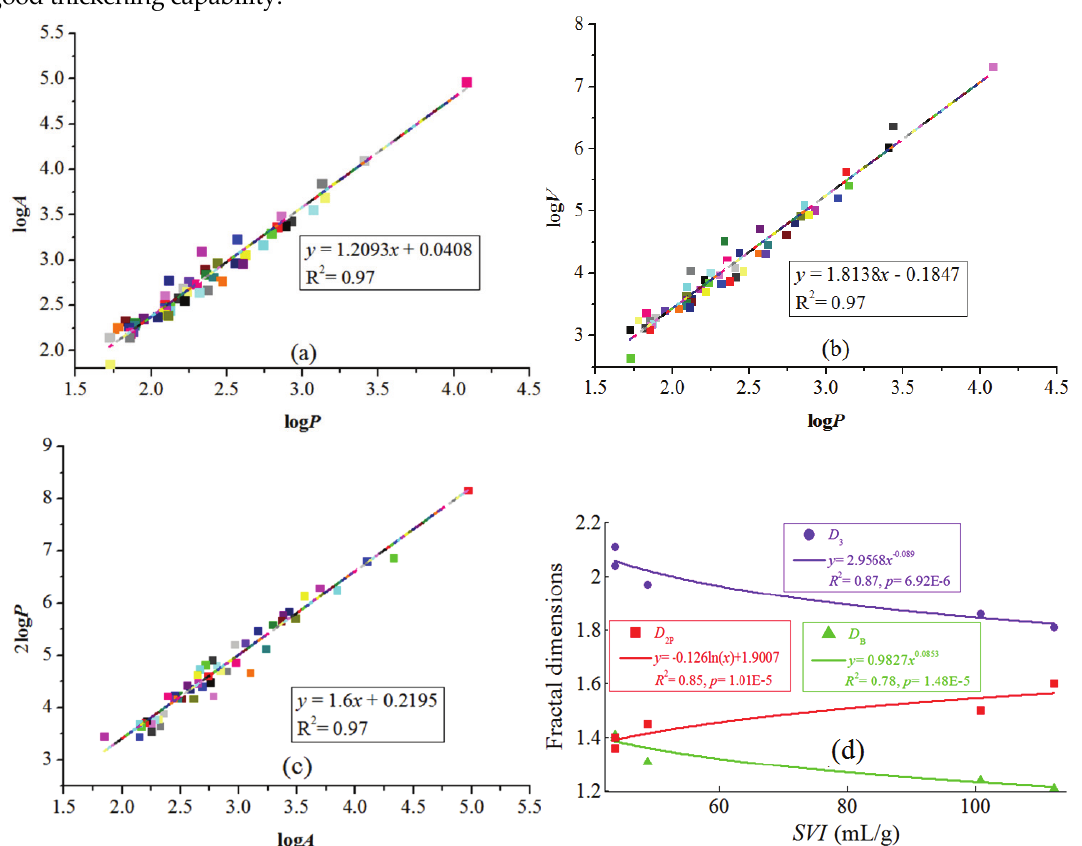
Figure 6. ( a – c ) The D 2 , D 3 , and D B for the sludge flocs from wastewater treatment plant (WWTP) 5, ( d ) The D 2 , D 3 , and D B for the sludge flocs from WWTPs